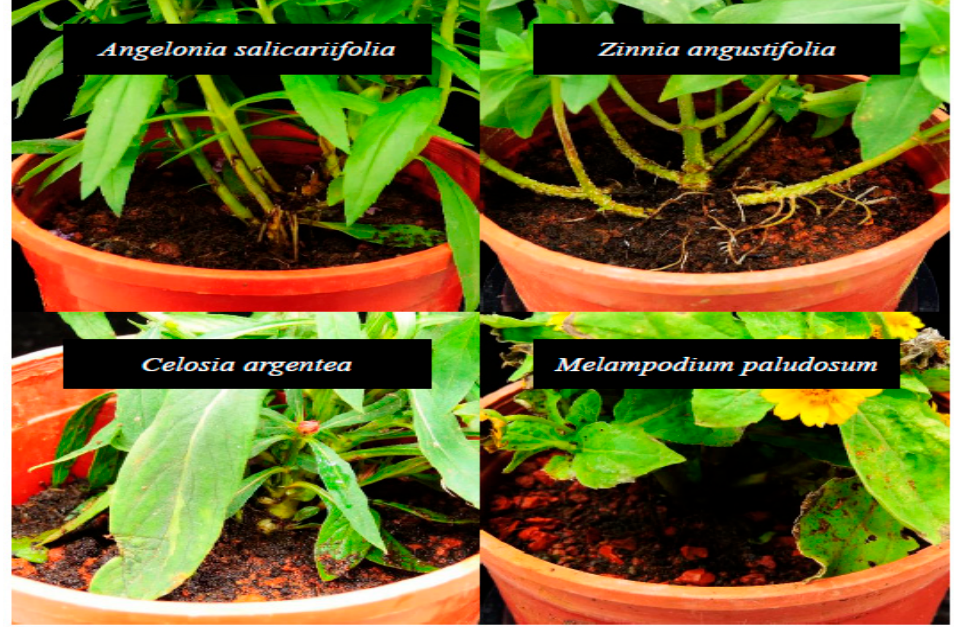
Figure 3. Adventitious roots growth of angelonia, narrow-leaf zinnia, celosia, and medallion flower at 10 days of waterlogging.